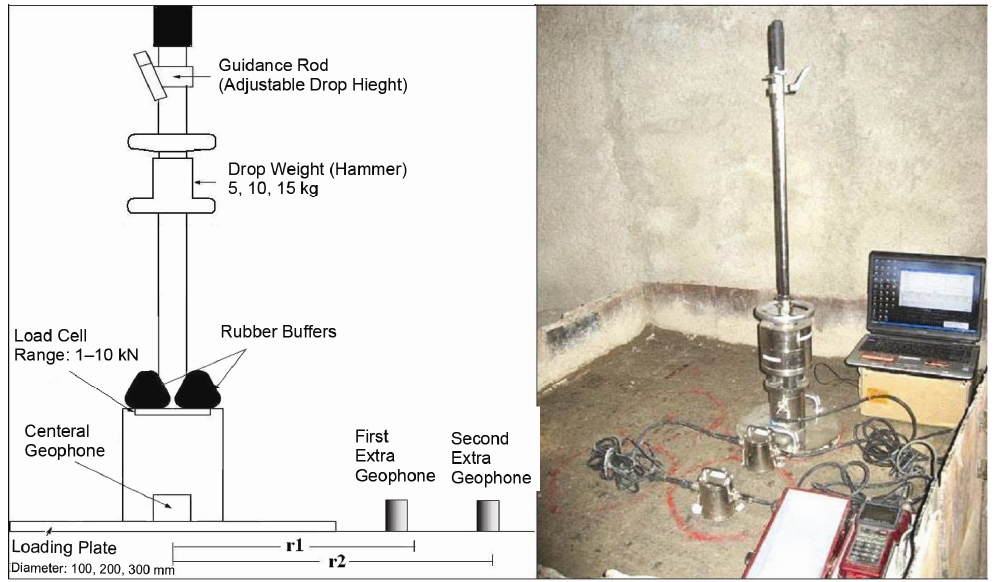
Fig. 1. A Schematic of a Portable Falling Weight Deflectometer (PFWD)